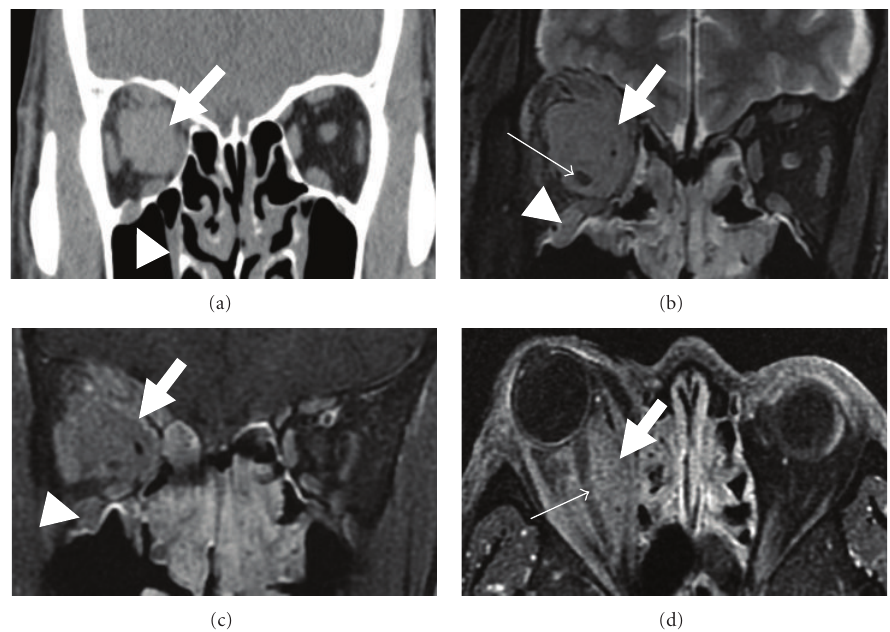
Figure 2: CT (a) and MRI (b: T2-weighted image; (c and d): contrast-enhanced T1-weighted images) of orbital space in 44-year-old man (case 4). Soft tissue mass is detected in the right orbital space (a; arrow). This lesion extends along the right optic nerve in MRI (b–d; arrows). The right optic nerve penetrating the lesion is detectable in MRI (b and d; small arrows). Soft tissue mass along the right infraorbital nerve is also noted (a–c; arrowheads).